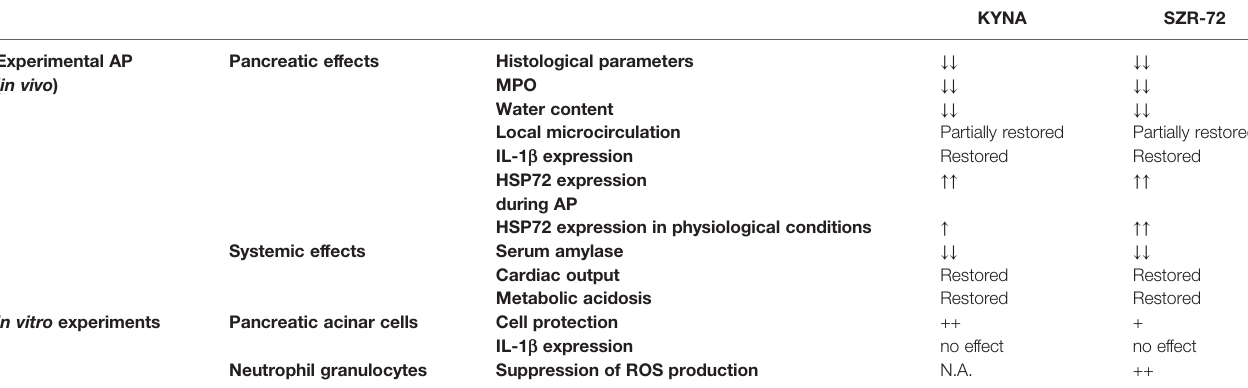
TABLE 2 | Summarizing the effects ( in vivo : 300 mg/kg; in vitro : 250 µM) of KYNA and SZR-72 in